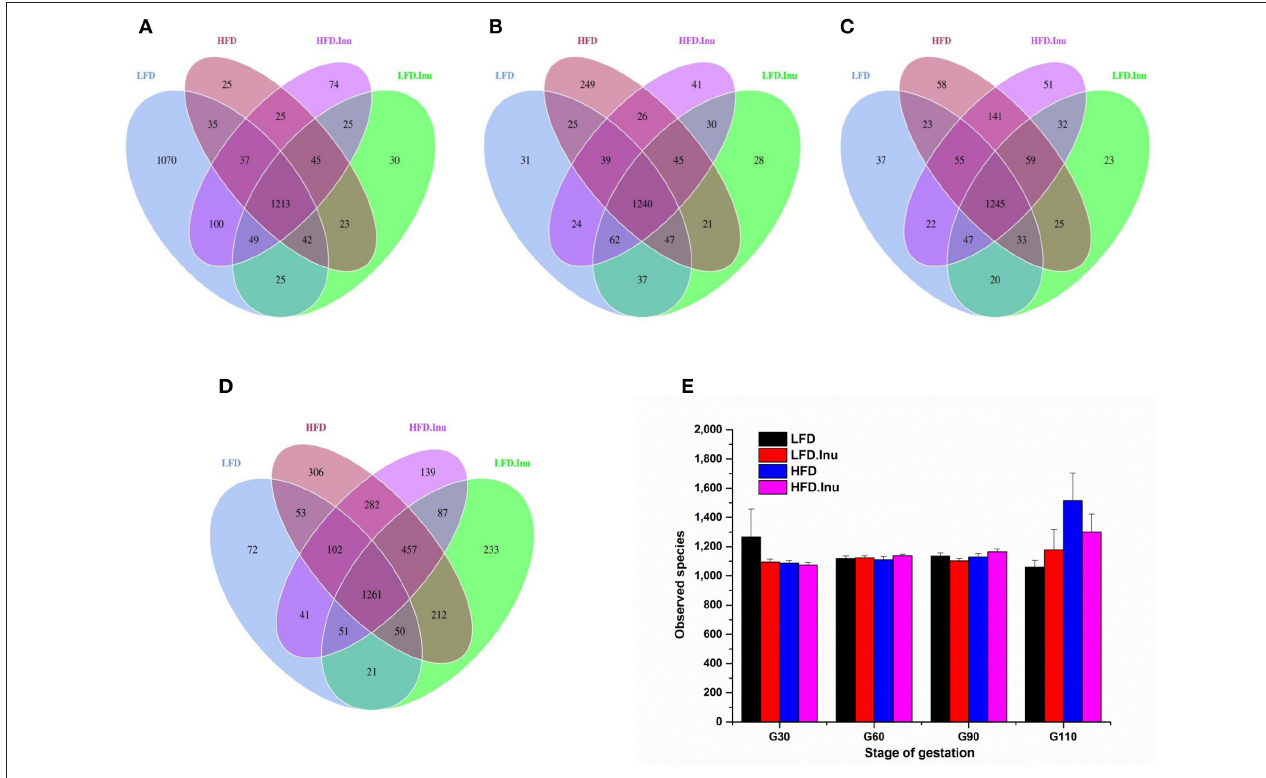
FIGURE 3 | Comparison of the OTUs among treatments at each gestation stage. The observed OTUs sharing ≥ 97% sequence similarity. ( A–D ) Venn diagrams were generated to describe the common and unique OTUs among treatments at d30, 60, 90, and 110 of gestation, respectively. (E) Observed species at different gestation stage. Sows were regarded as the experimental units, n = 5 for each treatment at each gestation stage except for LFD group on d90 and d110 with n = 4 due to an unexplained diarrhea on d88 of gestation which lasted for 2 days. LFD, low fat diet; LFD.Inu, low fat diet with inulin addition; HFD, high fat diet; HFD.Inu, high fat diet with inulin